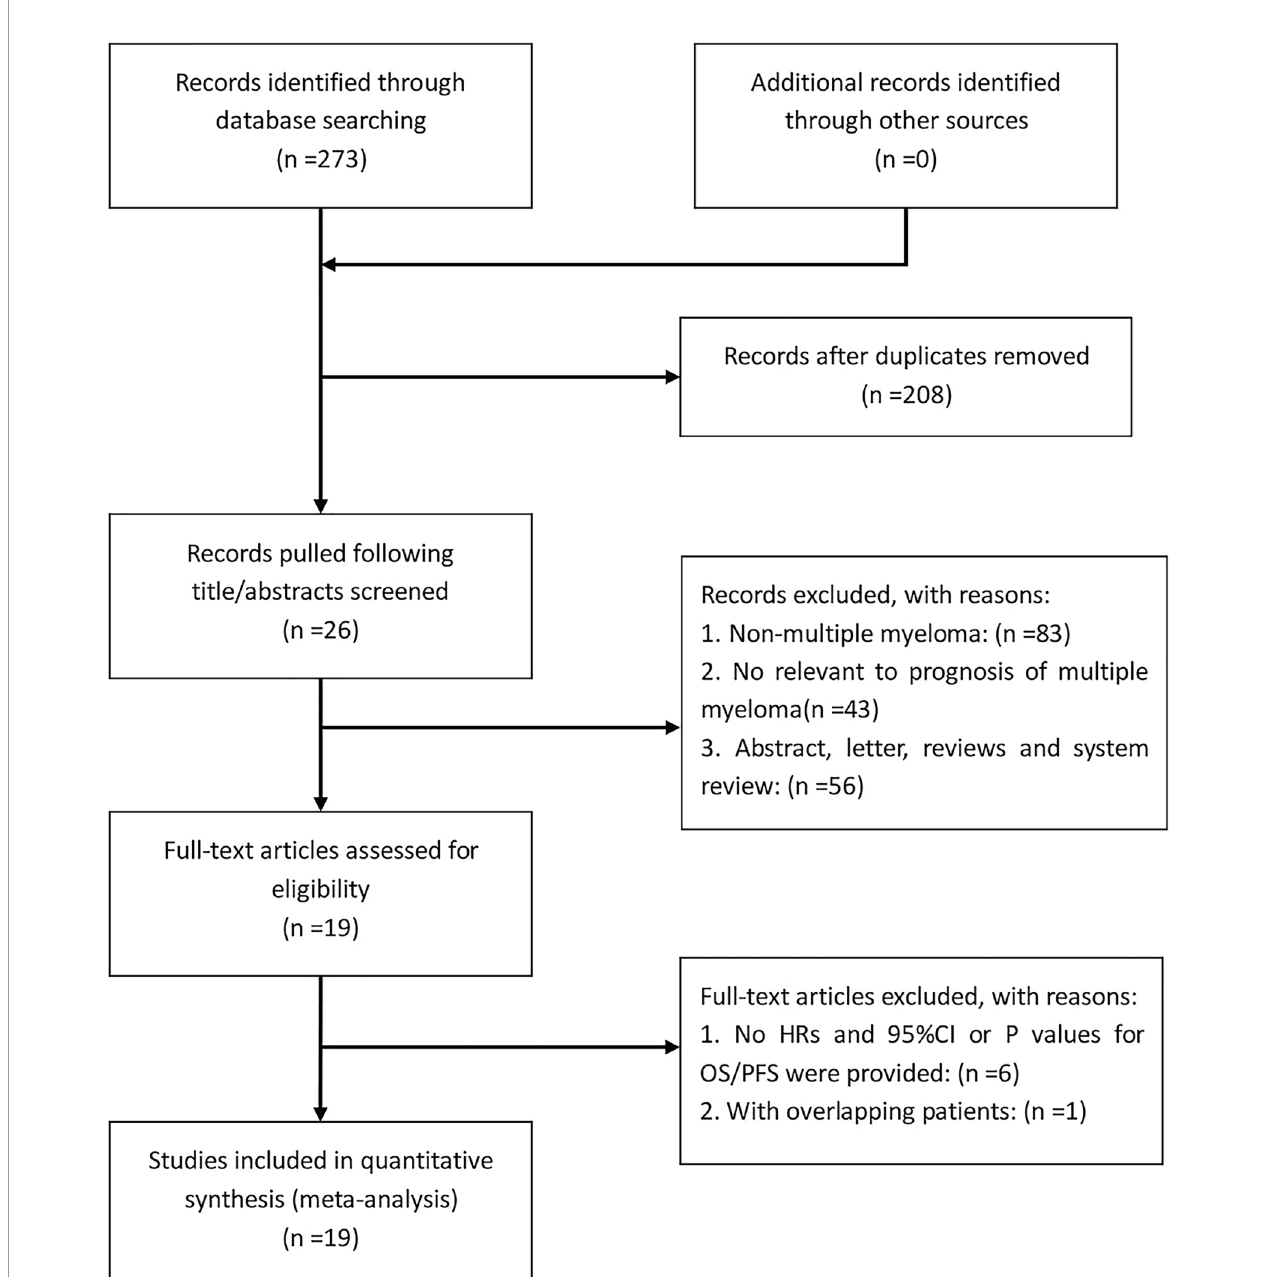
FIGURE 1 | Flow diagram showed the selection process of studies for